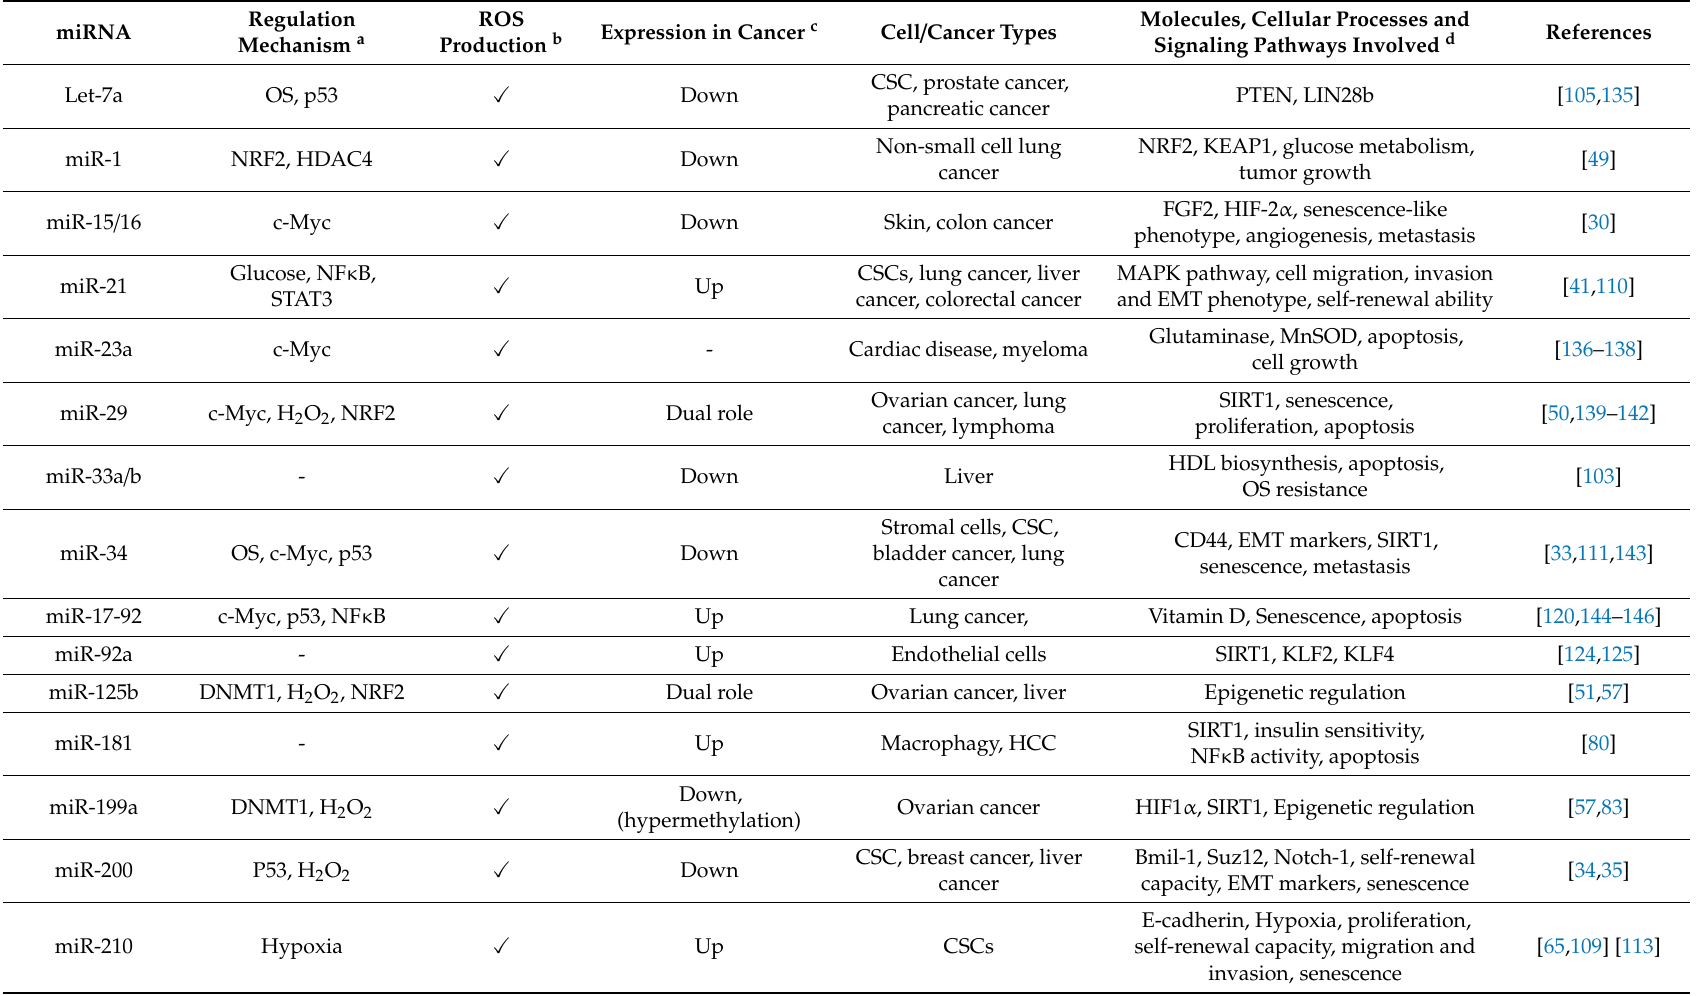
Table 1. ROS-related miRNAs and their potential mechanisms in